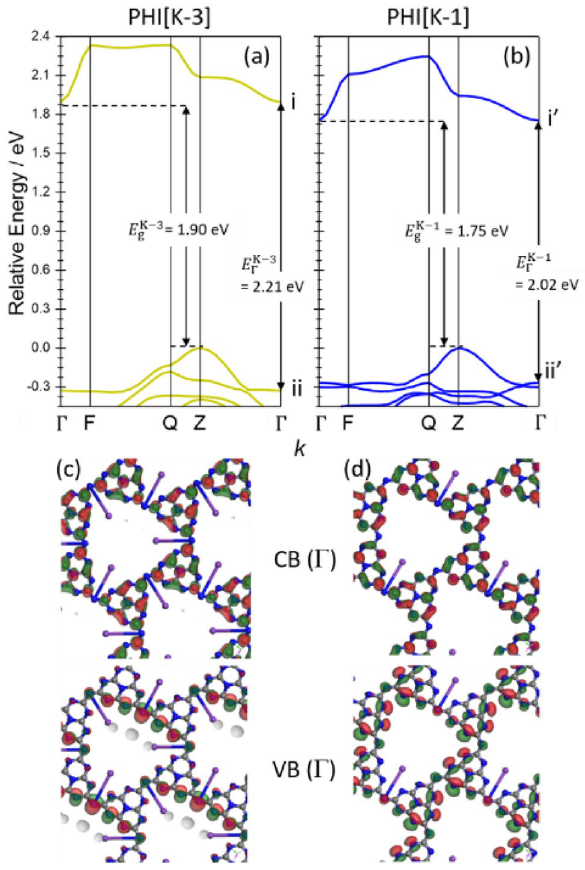
Figure 8. Energy band structures of PHI[K-3] ( a ) and PHI[K-1] ( b ) calculated by DFT. The left axes represent the energy measured from the top of the valence band. The letters on the bottom axes correspond to the letters in the Brillouin zones in Fig. S6c,d. Orbitals for valence band (VB) and conduction band (CB) at the Γ point of PHI[K-3] and PHI[K-1] are shown in ( c ) and ( d ), respectively. The green and red parts represent the lobe of the wavefunctions with opposite